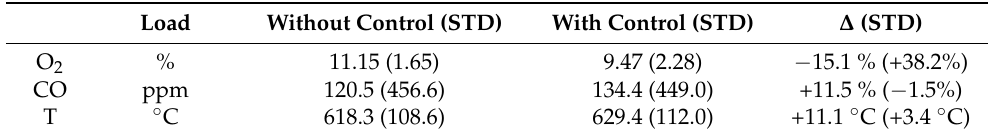
Table 1. Average oxygen and CO concentrations as well as temperatures at the outlet of the main combustion chamber and its corresponding standard deviations. The average and standard deviation were calculated over the sequences (a1), (a2), (b) and (c). The sequences (S1) and (S2) are not considered.